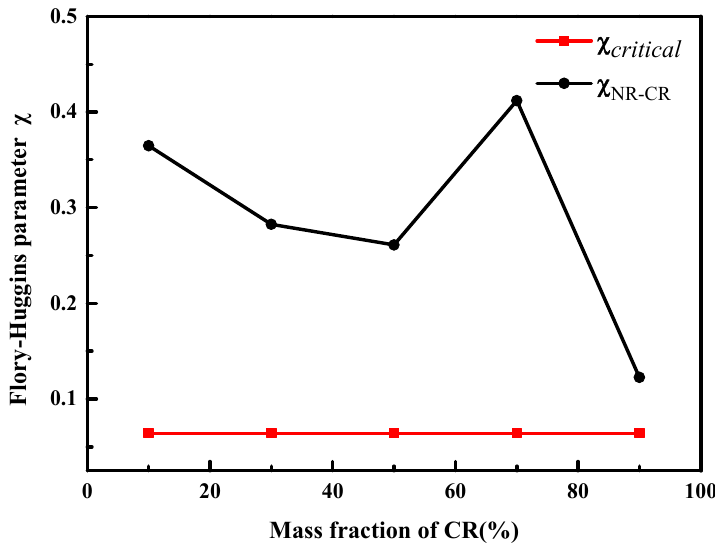
Figure 4. Flory–Huggins parameters of the NR/CR blends in different proportions. (Here, red line means the critical interaction parameter of NR/CR blends.)